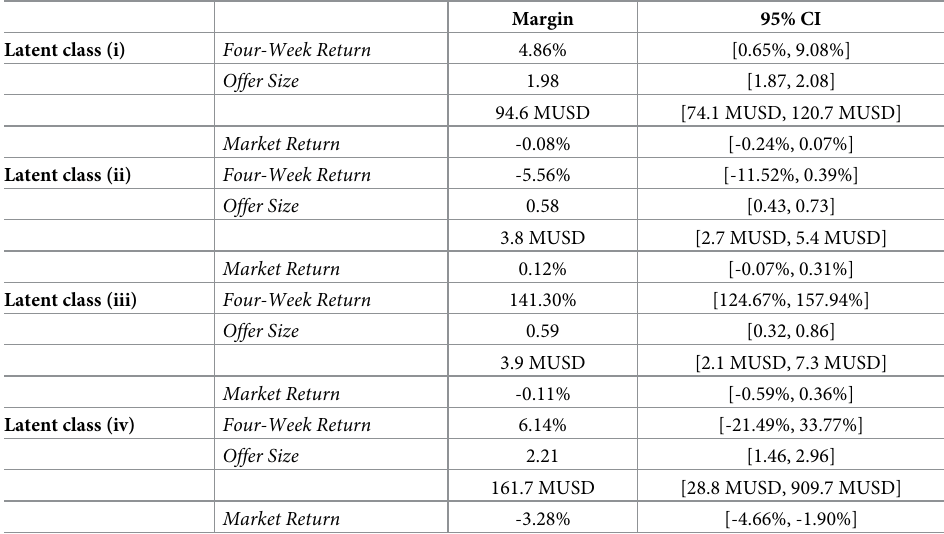
Table 7. Predicted latent class means using four-week returns on the issuing firms’ securities.